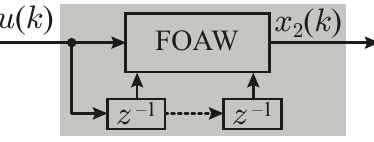
Figure 4. Block diagram of first-order adaptive windowing (FOAW).